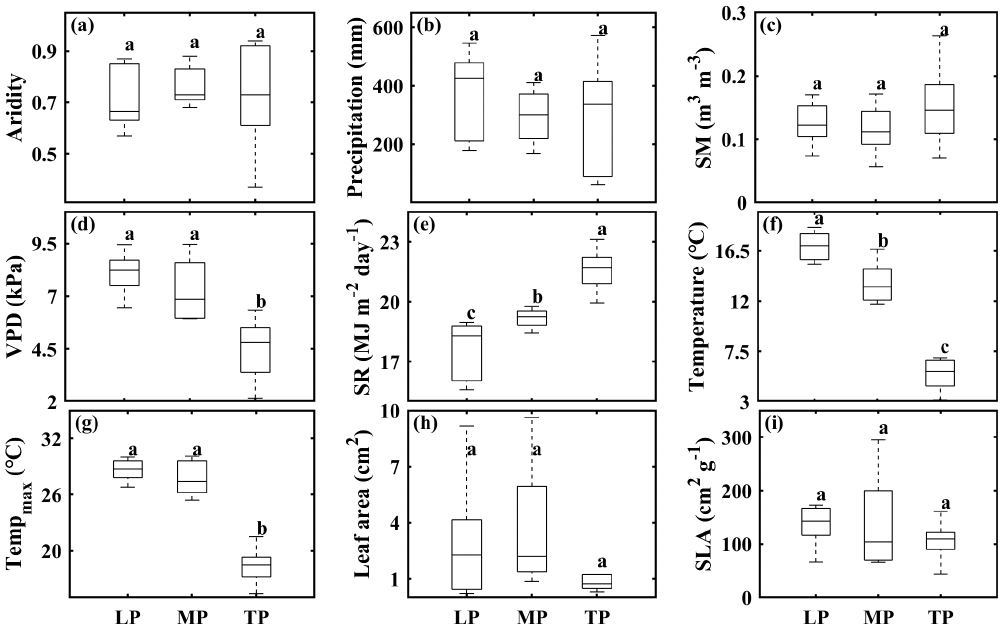
Figure 1. Comparison of aridity (a) , growing season precipitation (b) , soil moisture (SM) (c) , vapor pressure deficit (VPD) (d) , solar radiation (SR) (e) , temperature (f) , maximum temperature (Temp max ) (g) , community leaf area (h) , and specific leaf area (SLA) (i) among transects. The abbreviations used in the figure are as follows: LP – Loess Plateau, MP – Inner Mongolian Plateau, and TP – Tibetan Plateau. Lowercase letters indicate significant differences among transects ( P< 0 . 05). Error bars indicate the standard error of the mean; n =